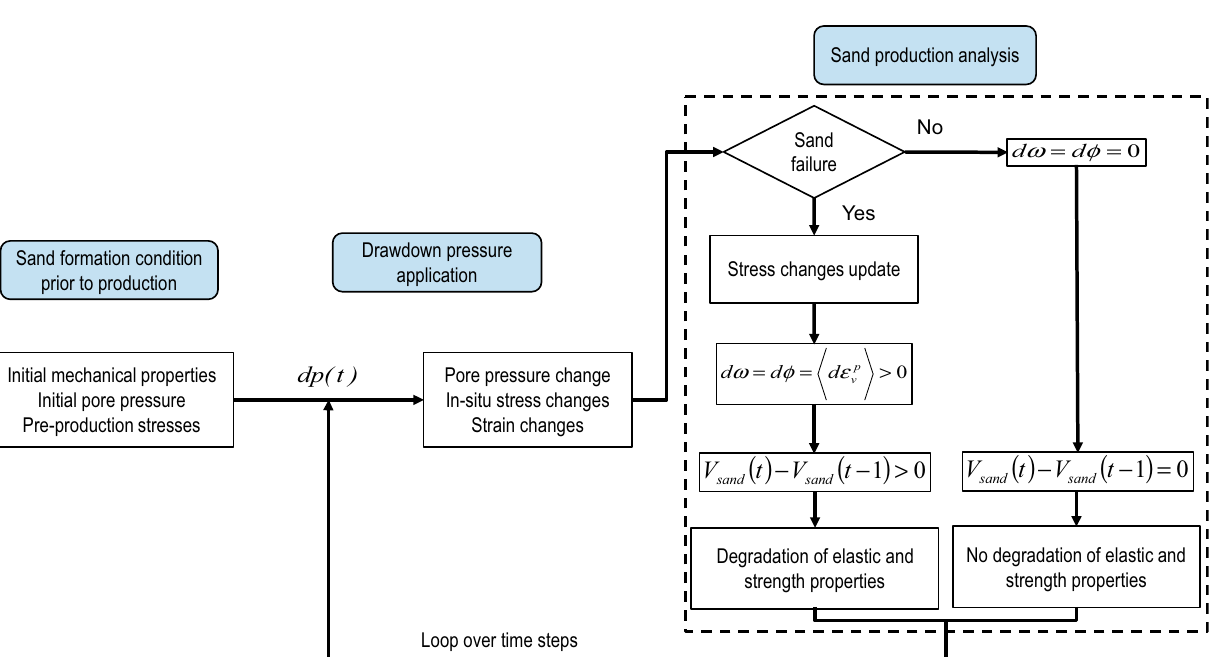
Fig. 3 Workflow for sand production